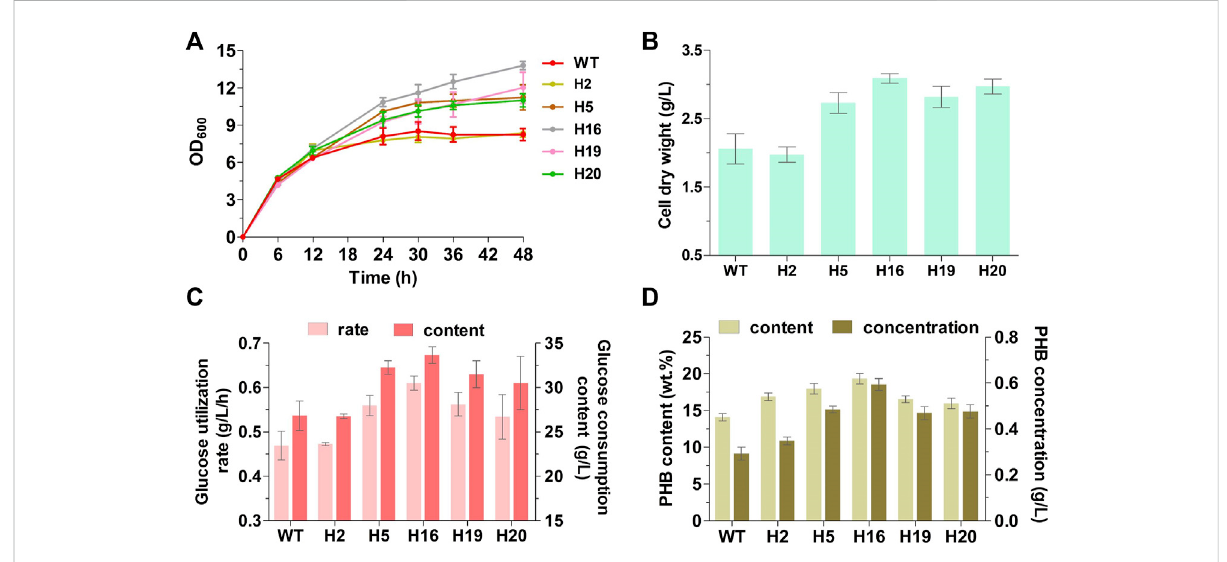
FIGURE 3 Fermentation performance of the genome-reduced mutants for PHB accumulation after 48-h cultivation. (A) The growth curves. Properly diluted fermentation broth was directly used for the measurement of OD 600 , which included the cell density and intracellular PHB. (B) The fi nal cell dry weight; (C) The glucose utilization rate and accumulative consumption content; (D) The PHB content (g/g cell dry weight × 100%.) and concentration. WT represents wild-type MG1655. Data are expressed as means (±s.d.) from three independent